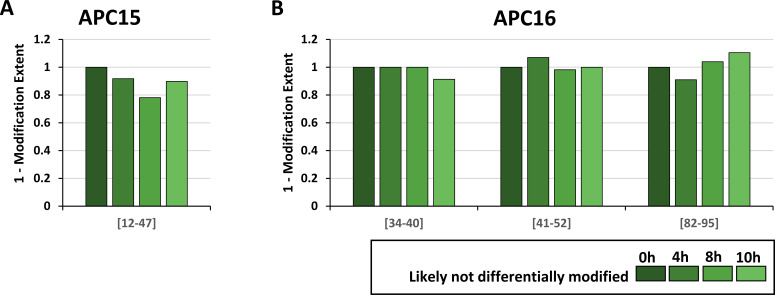
FLEXIQuant-LF analysis of APC/C components as superprotein.Peptide classification and extent of modification of (A) APC15 and (B) APC16 analyzed with FLEXIQuant-LF using the ‘superprotein’ approach as number of peptides per protein was below threshold of five peptides. Green bars indicate peptides that were classified as likely not differentially modified at 10 hr (RM score ≥0.6). Positions of peptides within the protein are given from the N- to C-terminus.